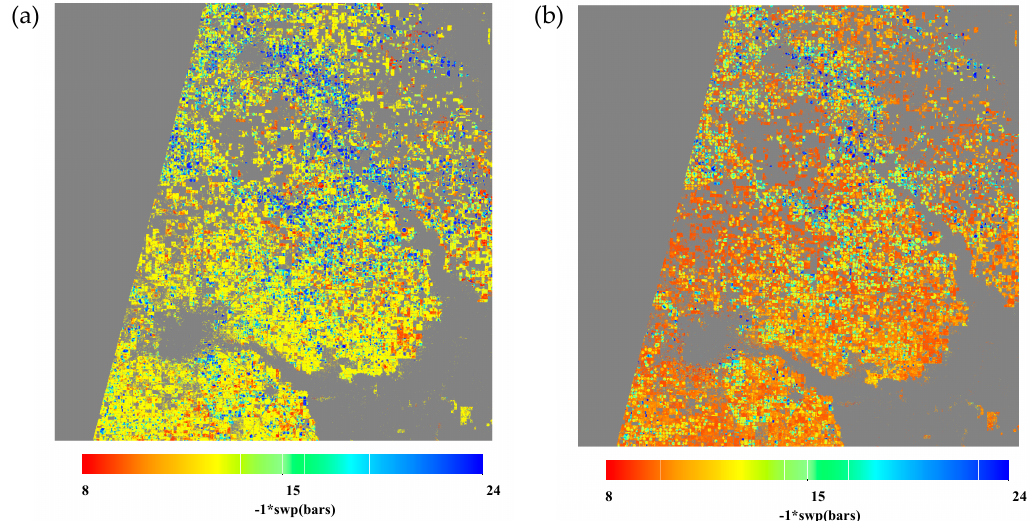
Figure 7. Stem water potential images derived from ( a ) random forest regression method and ( b ) linear regression method from Sentinel-2. The region is approximately 110 by 110 km. The 2018 Crop Data Layer (CDL) was employed to mask out non-cotton areas (grey color).